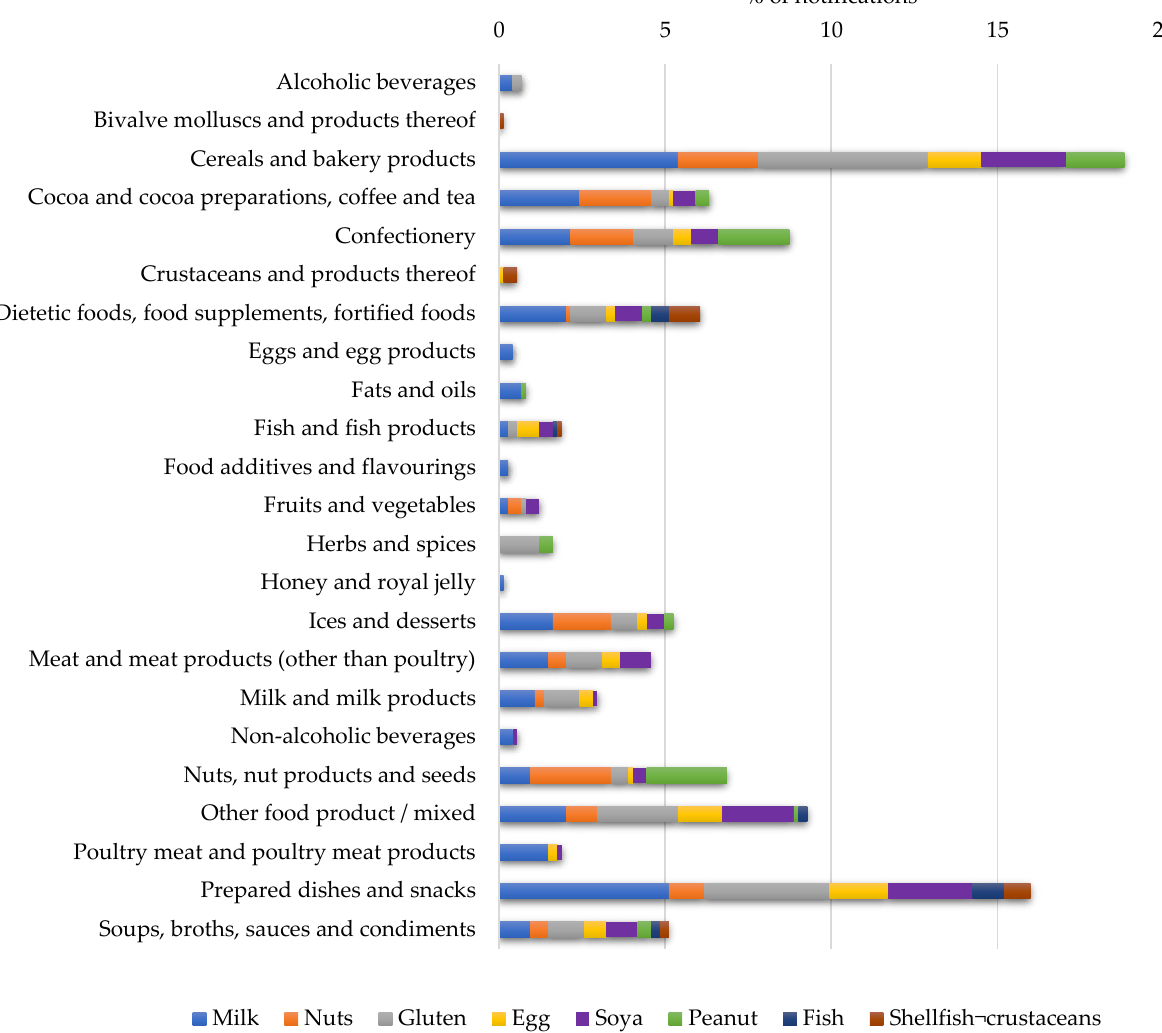
Figure 7. Relationship between the main allergens affecting the pediatric population and their presence within each food category.